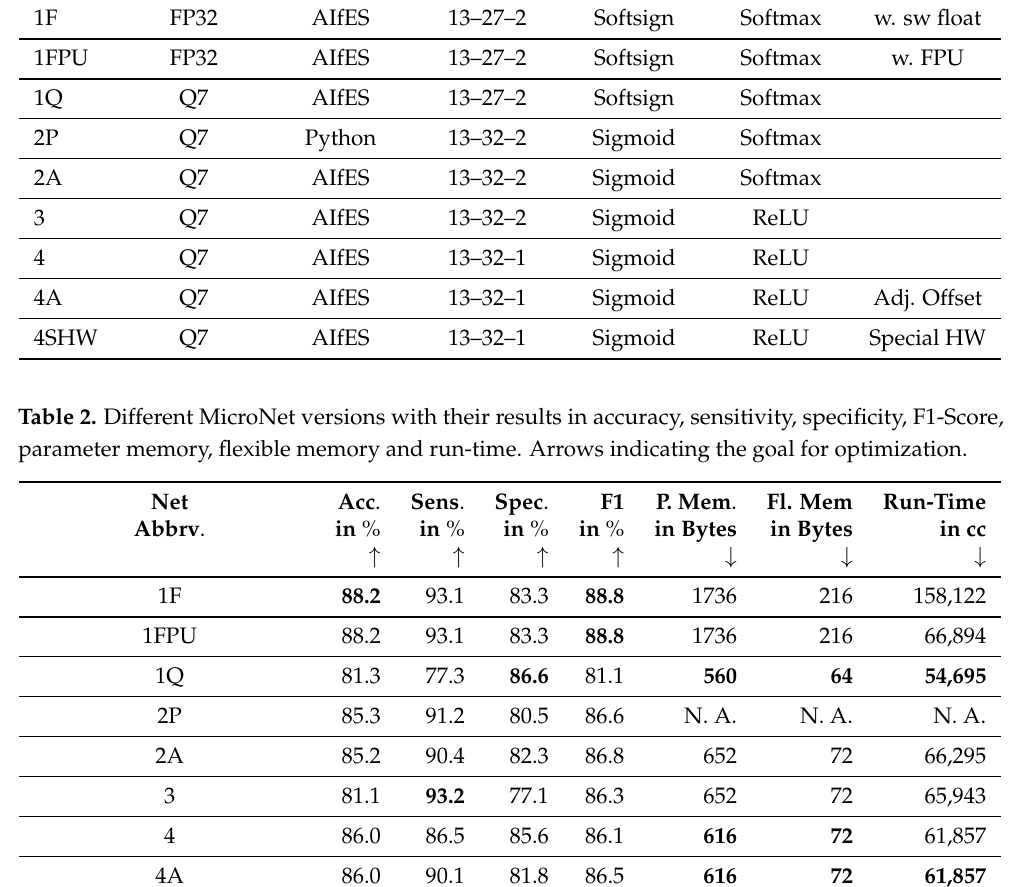
Table 1. Different MicroNet versions with their structures. Net Data Run in Structure Activ. Funct. Notice Abbrv .